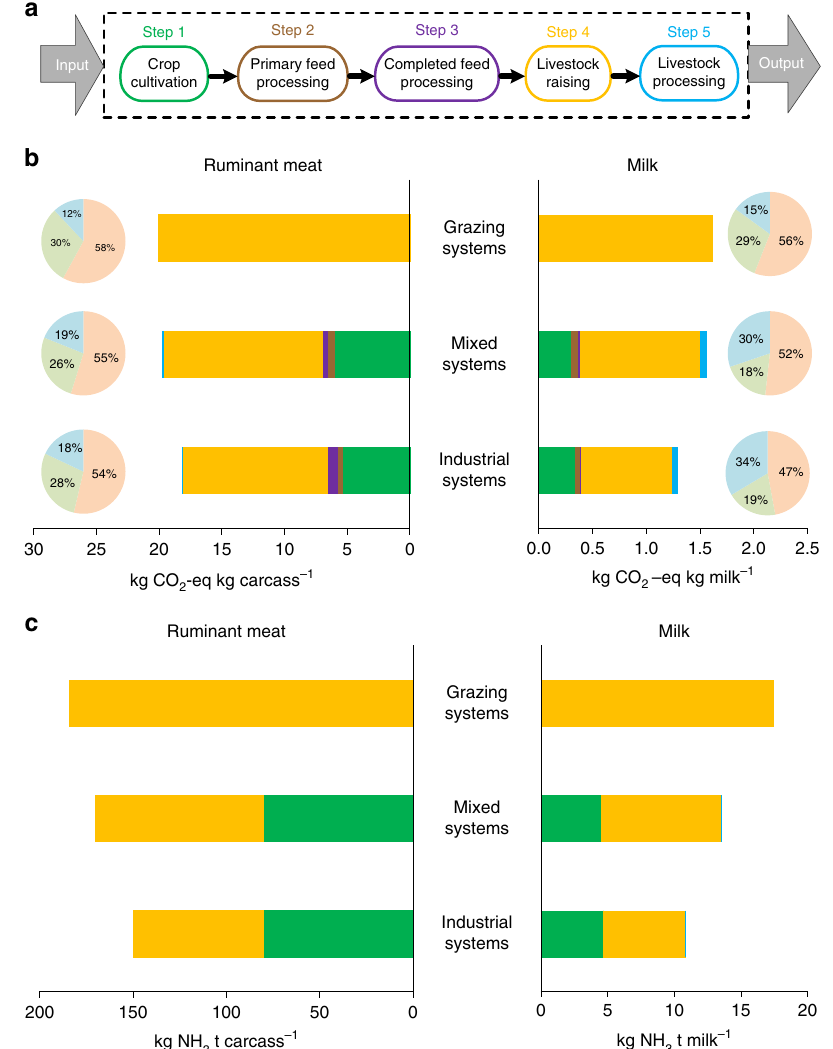
Fig. 3 China ’ s current level of production technology indicated by emissions intensity. The steps of the ruminant production chain ( a ), including crop cultivation, primary feed processing, completed feed processing, livestock raising, and livestock processing. The GHG ( b ) and NH 3 ( c ) emissions intensities in each of the steps in ruminant meat and milk production. The light blue, yellow, and green in the pie chart in b represents CH 4 , N 2 O, and CO 2 emissions, respectively. The production contribution of each production systems in China see Supplementary Fig. 8, and the diagrams of the calculators